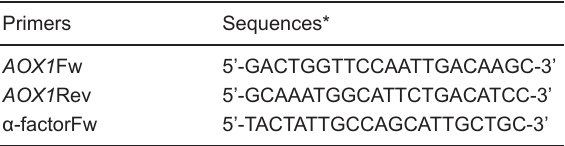
Table 2. Primers for the detection of recombinant Pichia clones.